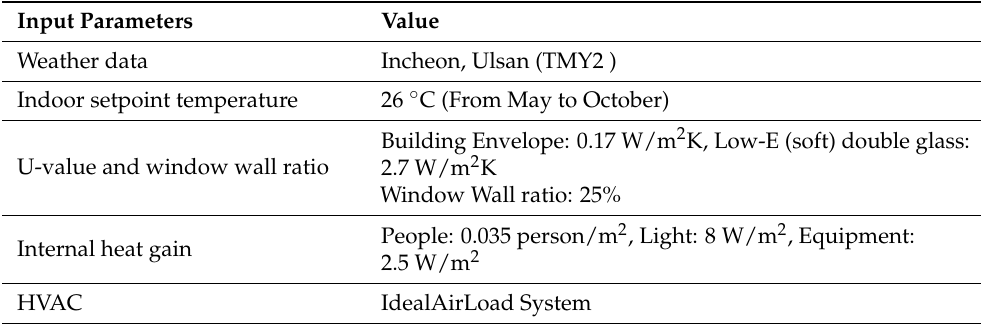
Table 2. Default input values for Energyplus simulation.